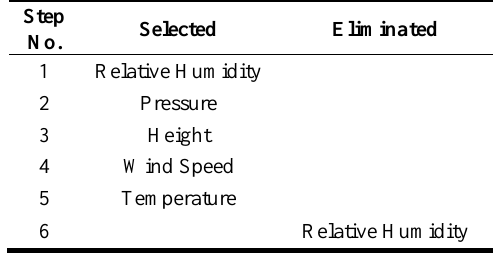
Table 9. Step-wise Regression results